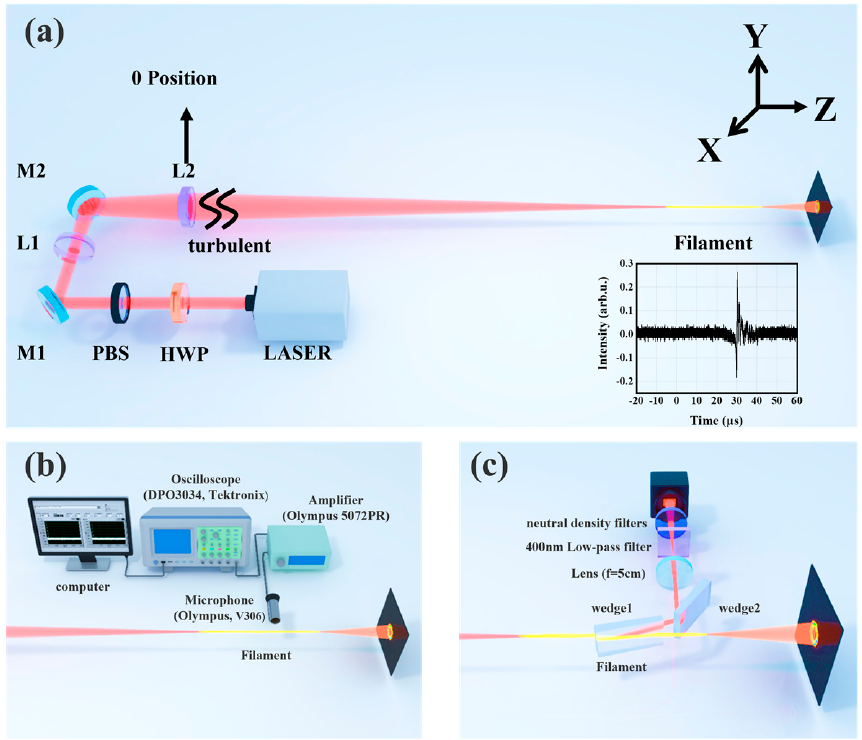
Figure 1. ( a ) Schematic diagram of the experimental device. Inset is a time-domain diagram of the filament-excited ultrasonic signal; ( b ) experimental apparatus for recording ultrasonic signal induced by filament under turbulent conditions; ( c ) experimental apparatus for recording the central drift of filaments under turbulent conditions.